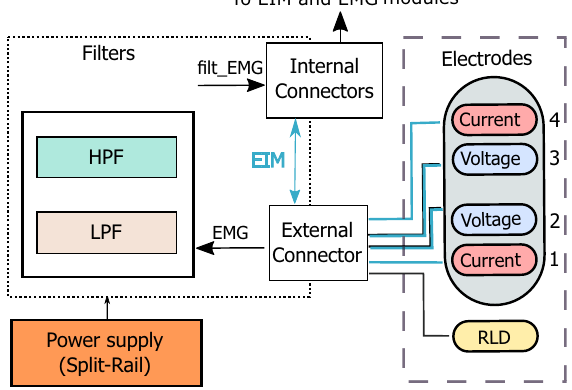
Figure 3. Block diagram of electrodes and filter